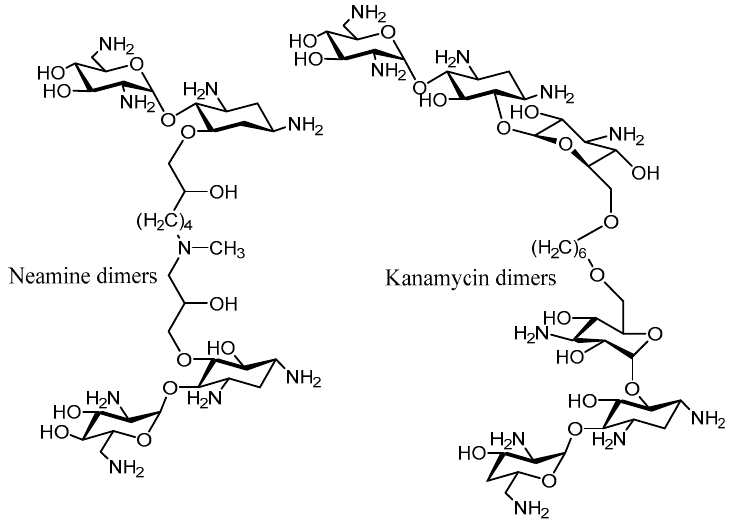
Figure 8. Structure of the Neamine and kanamycin dimers.